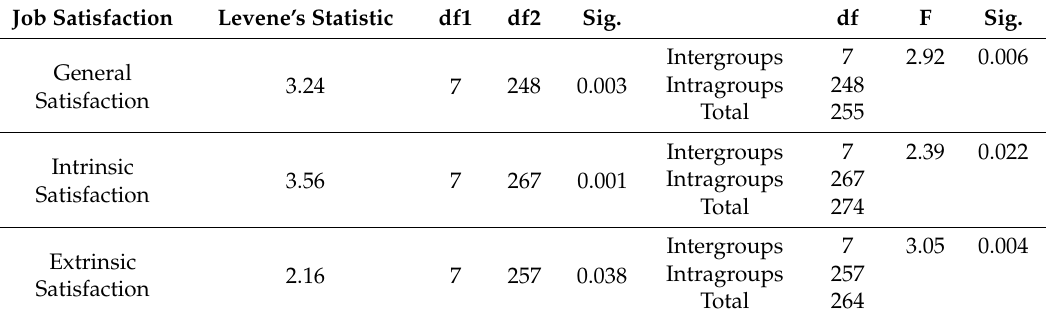
Table 2. Relationship between the General Satisfaction dimensions and the type of